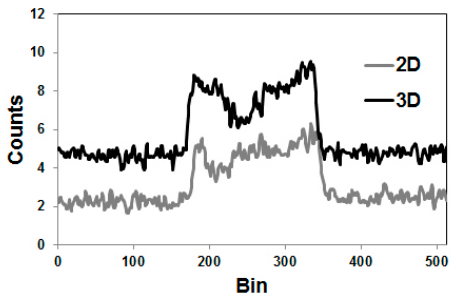
Figure 8. Profiles through sinograms of a rod phantom filled with 86 Y and recorded with the Siemens/ECAT Exact HR+ operated in both 2D- and 3D-mode. In 3D, the flat background is doubled.